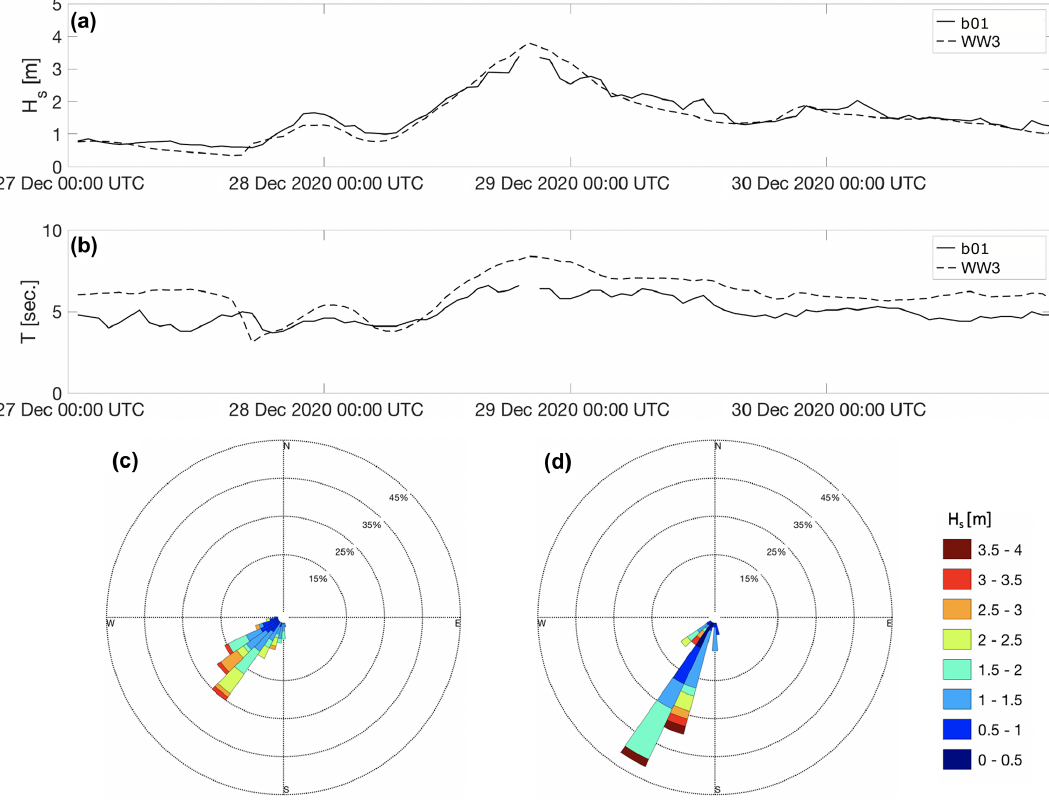
Figure 8. Comparison between in situ wave observation and simulation of significant wave heights and period (a, b) , directional distribution of the significant wave height occurrence (c, d)